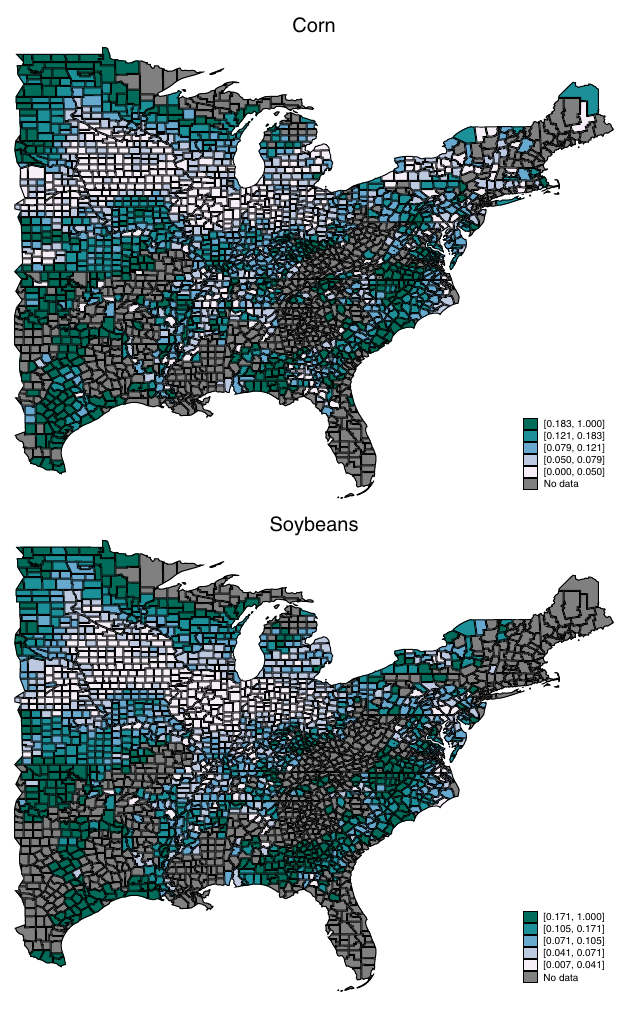
Fig. 2 Spatial distribution of county-level aggregate loss – cost ratios (LCR), 1989 – 2014 averages ( N = 30,261 for corn and N = 29,014 for soybeans). The darker colors represent higher average